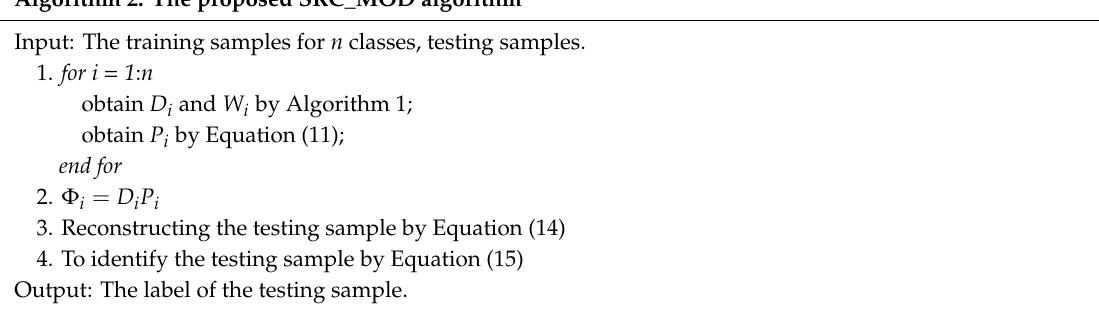
Figure 5. Residuals between the original sample and reconstructed samples. Algorithm 2. The proposed SRC_MOD